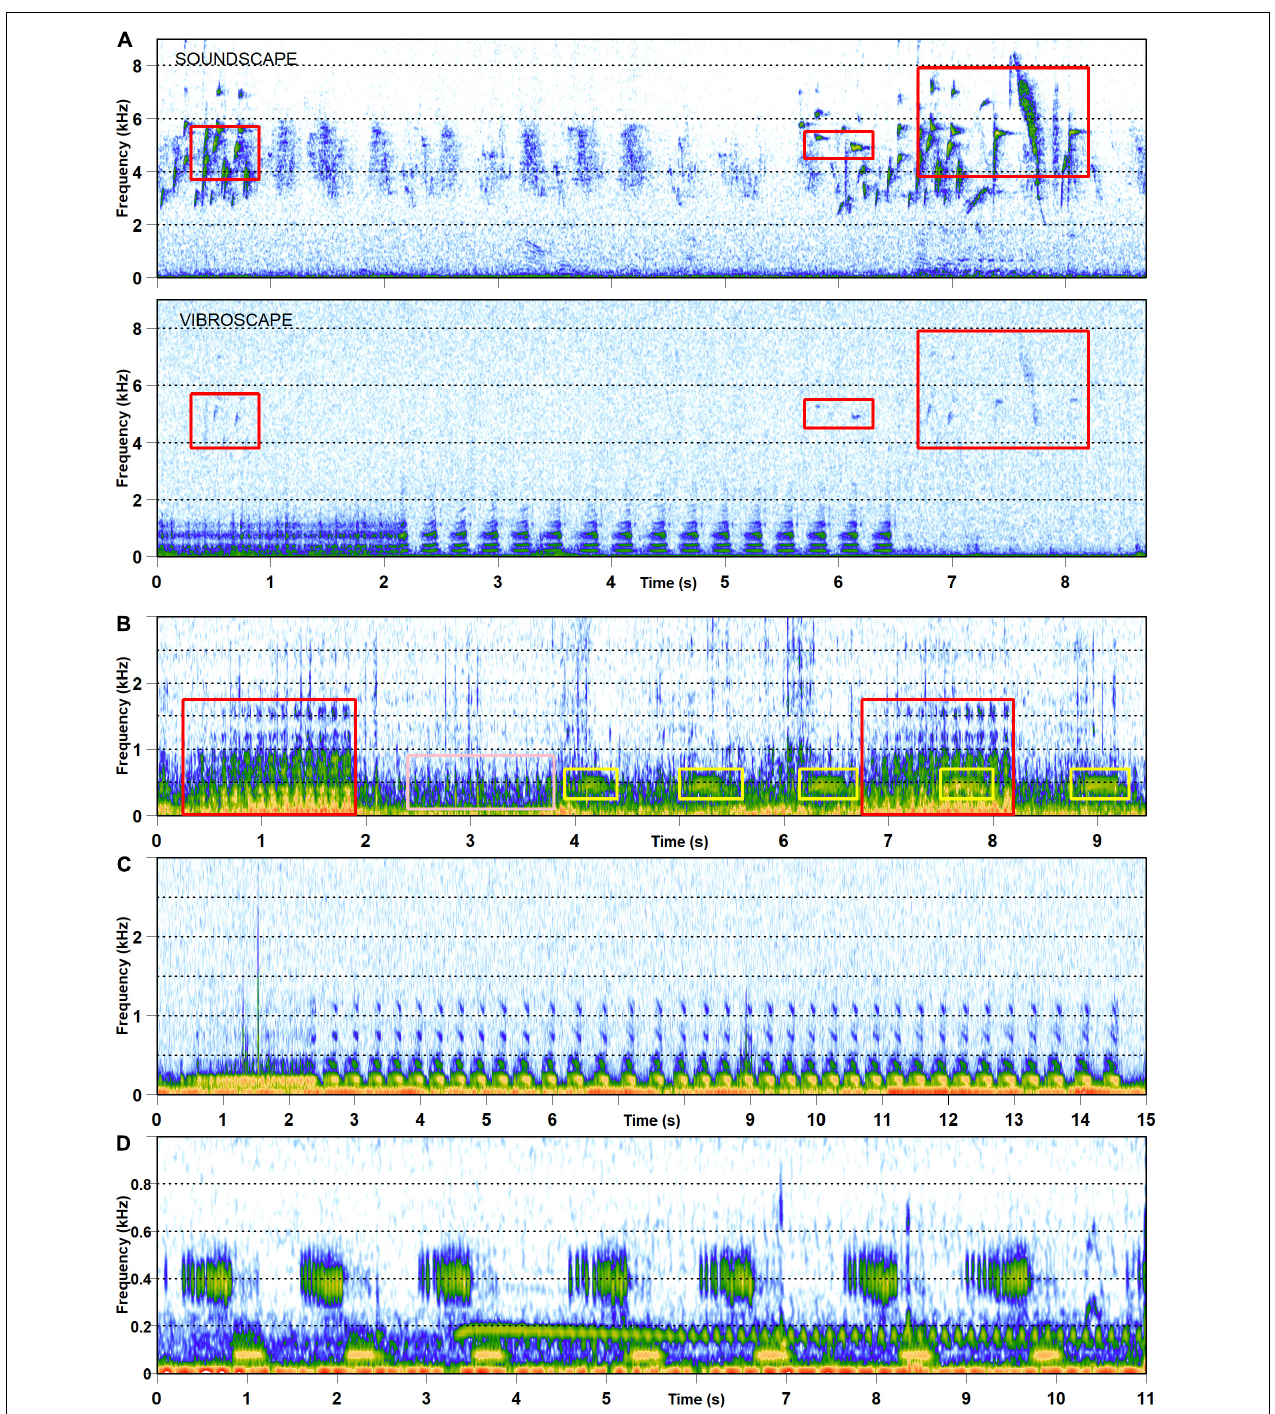
FIGURE 2 | Visualizations of the vibroscape recorded by laser vibrometer in the form of spectrograms. (A) Simultaneous recording of soundscape (above) and vibroscape (below) from Bistra (Slovenia) meadow on July 6, 2021. Vibroscape was recorded on wild strawberry ( Fragaria vesca ). Red frames indicate bird songs of European goldfinch ( Carduelis carduelis ) observed on both channels; (B) Vibroscape recorded on herbaceous plant hedge bedstraw ( Galium mollugo) in a hay meadow at Bistra (Slovenia) on July 7, 2018. Frames of different color indicate different types of vibrational signal (species unknown). Note strong constant background vibrational noise induced by wind in the frequency range up to 1 kHz. (C) Vibroscape recorded from a spider web (from f. Lyniphidae) includes vibrational signals of the Aphrodes bicincta in a hay meadow at Bistra (Slovenia) on July 14, 2020. (D) Vibroscape recorded on a dogwood bush ( Cornus sanguinea) at Bistra on June 20, 2019 (signallers unknown). All spectrograms obtained with the R package seewave (Sueur et al., 2008).